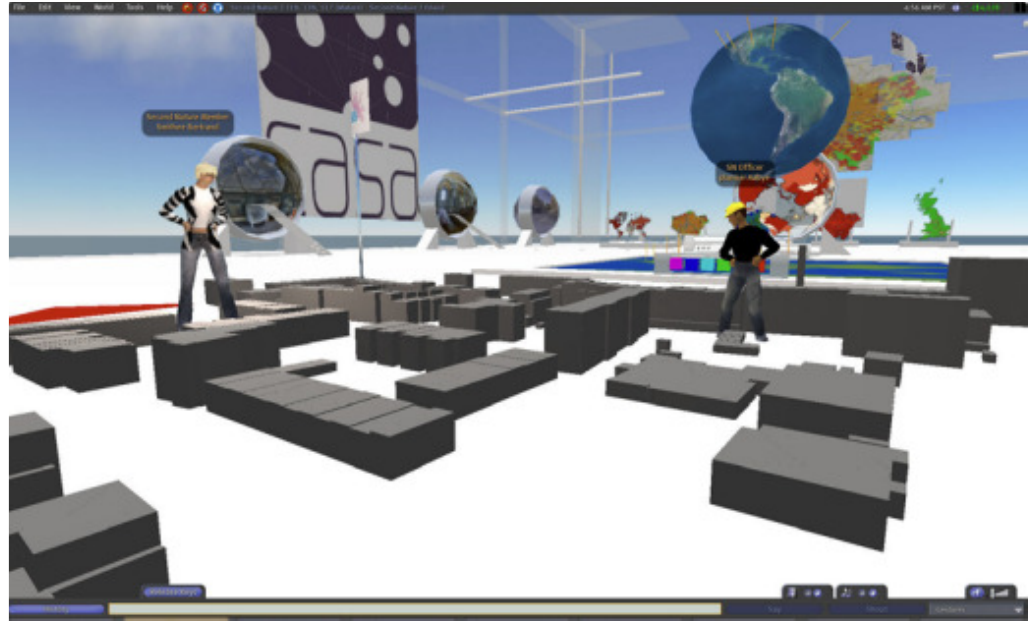
Figure 3. Building virtual London in Second